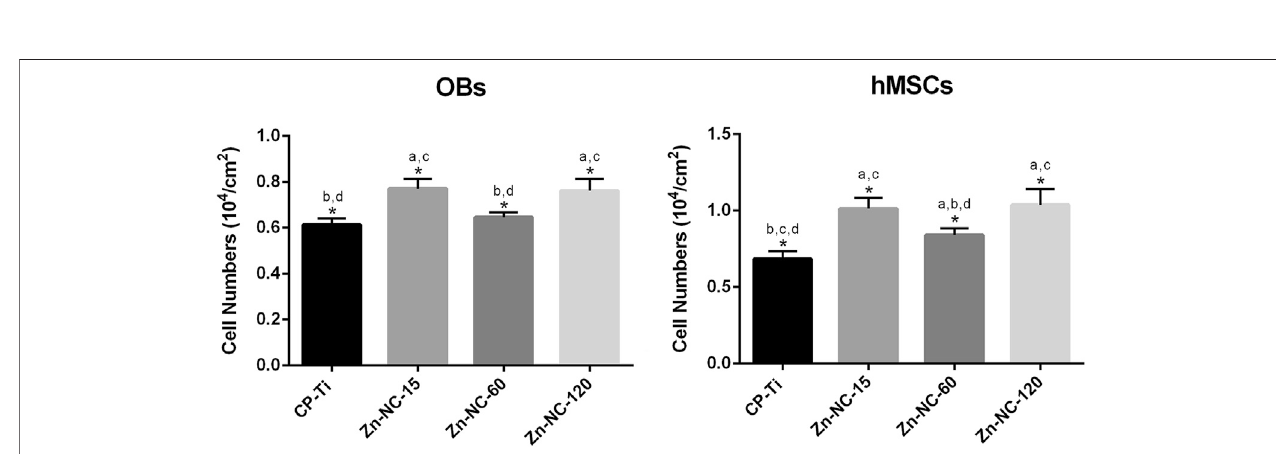
FIGURE7| Adhesion ofOBsandhMSCsonthedifferentsurfacesanalyzed bycounting theDAPI-stained nucleiafter 1 hofincubation (n (cid:2) 3).* p < 0.05; a P < 0.05 vs. CP-Ti; b P < 0.05 vs. Zn-NC-15; c P < 0.05 vs. Zn-NC-60; d P < 0.05 vs. Zn-NC-120.